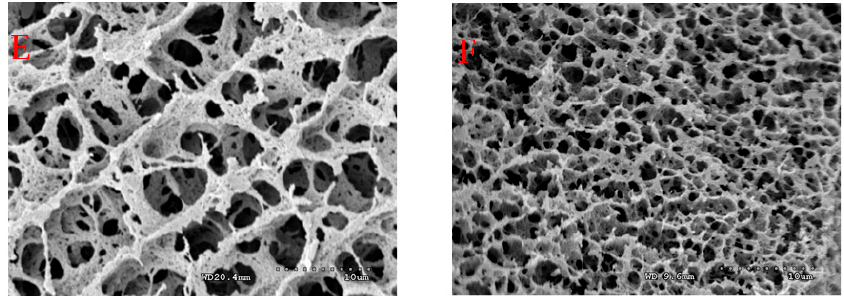
Figure 2. Cryo-scanning electron microscopy images of gels prepared from casein particle dispersions (( A ) without mTGase and trisodium citrate, ( B ) With mTGase but without trisodium citrate, ( C ) TG-10 in route 2, ( D ) 10-TG in route 1, ( E ) TG-30 in route 2, and ( F ) 30-TG in route 2). Magnification = 3000×. The cross-linking degrees of TG, TG-10, TG-20, and TG-30 were 19.9 ± 1.5%, 17.9 ±